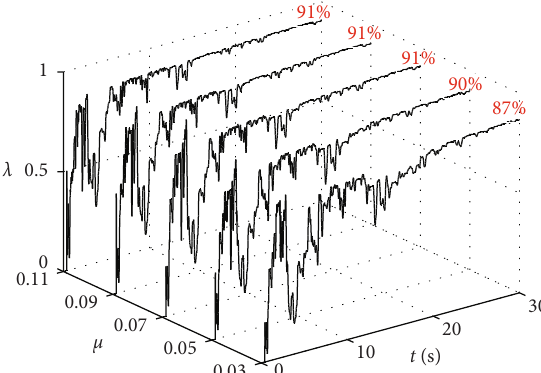
Figure 16: Time history response of energy consuming ratio when the Taft seismic wave T